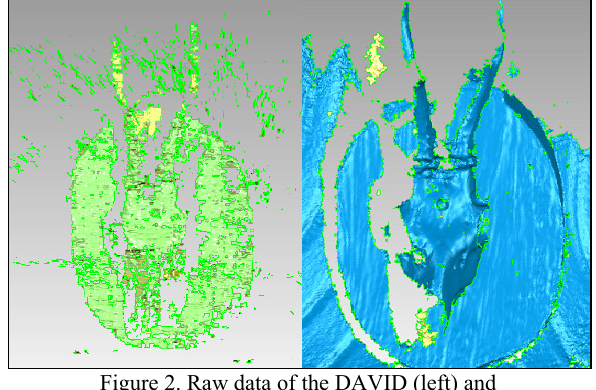
Figure 2. Raw data of the DAVID (left) and the ARTEC MH